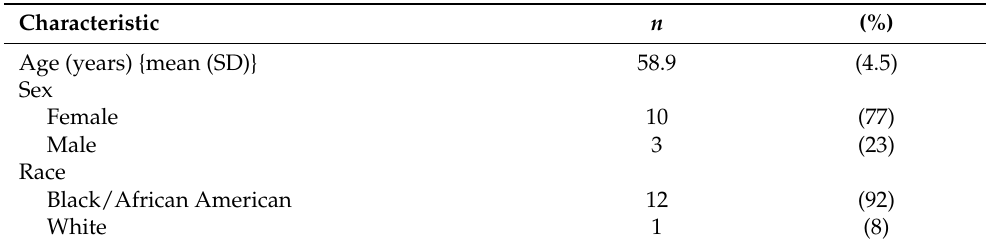
Table 2. Participant characteristics at